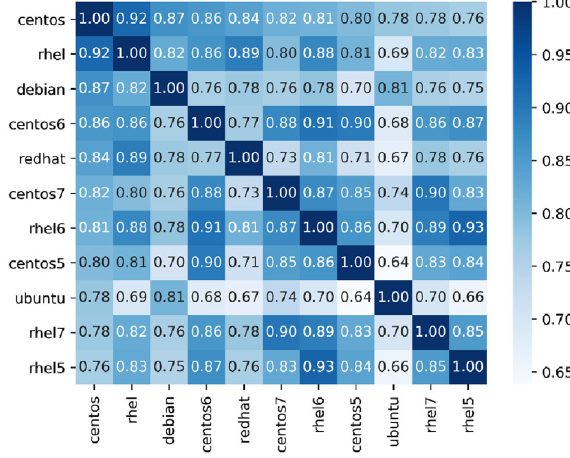
Fig. 7 Examples of similar words and their semantic